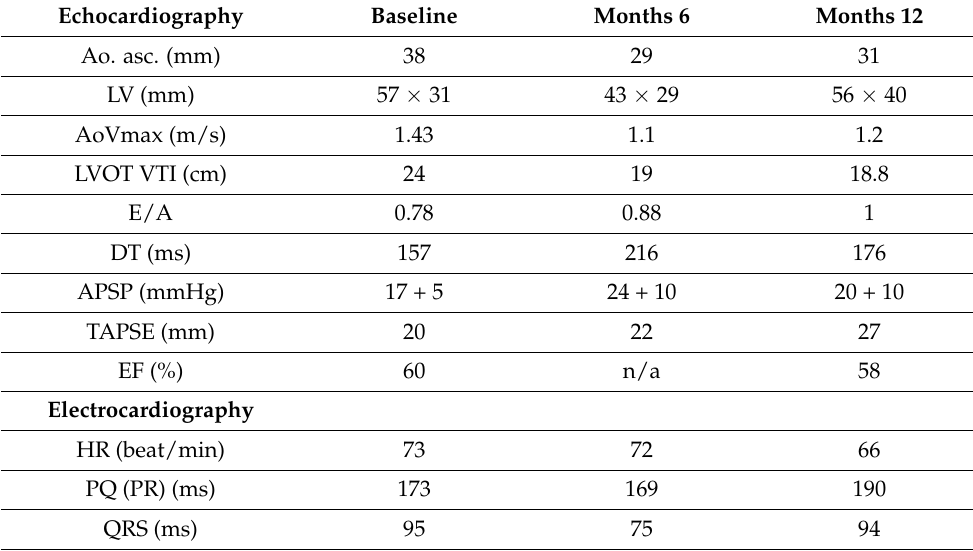
Table 1. Changes in physiological parameters.